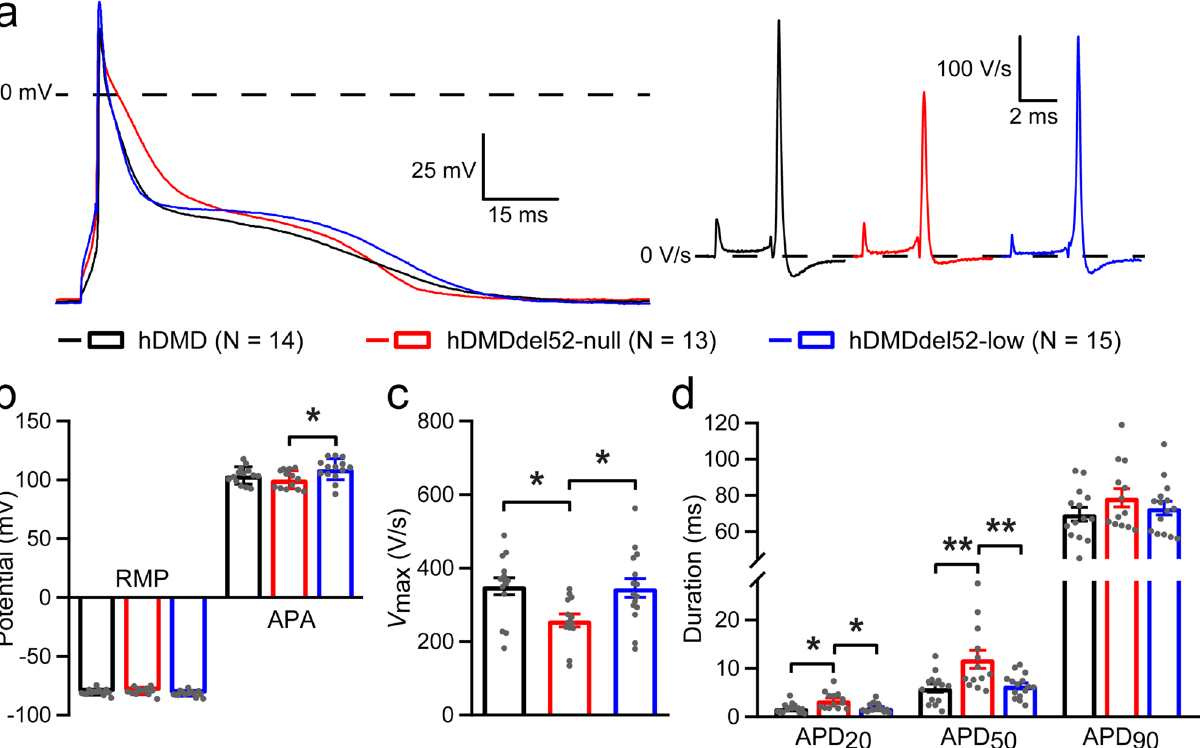
Figure 3. Single-cell action potential (AP) measurements reveal reduced action potential upstroke velocity and action potential duration prolongation upon loss of dystrophin, which is prevented by low dystrophin levels. ( a ) Typical examples of APs triggered at 2 Hz (left panel) and first derivative (d V /dt) of the AP upstroke (right panel) obtained in left ventricular cardiomyocytes from young hDMD (2.53 ± 0.03 months), hDMDdel52- null (2.37 ± 0.03 months), and hDMDdel52-low (2.43 ± 0.09 months) mice. ( b ) Average resting membrane potential (RMP) and AP amplitude (APA). ( c ) Average maximal AP upstroke velocity ( V max ). ( d ) Average AP duration at 20, 50, and 90% of repolarisation (APD 20 , APD 50 , and APD 90 respectively). N represents the number of cardiomyocytes measured. Cardiomyocytes were isolated from 3 hDMD, 2 hDMDdel52-null, and 3 hDMDdel52-low mice. * P < 0.05, ** P < 0.01 (one-way ANOVA with Tukey’s post-hoc test, Kruskal–Wallis with Dunn’s post-hoc test for APD 20